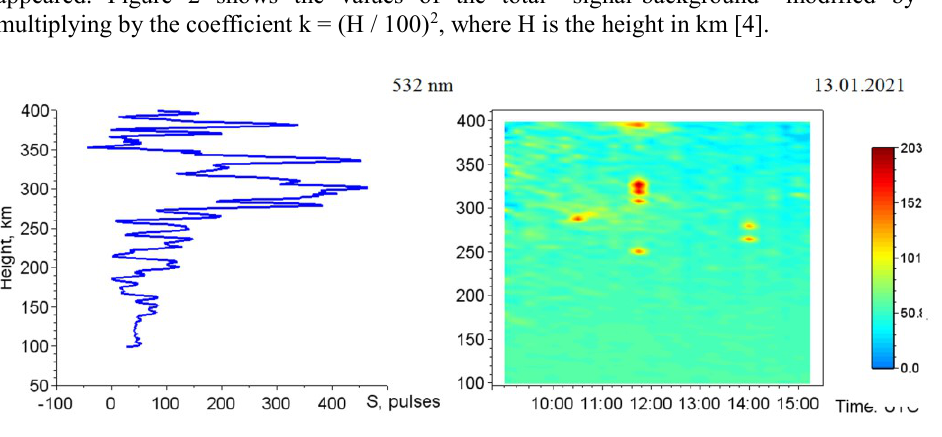
Fig. 2. Lidar “signal-background” plotted according to data from January 13,